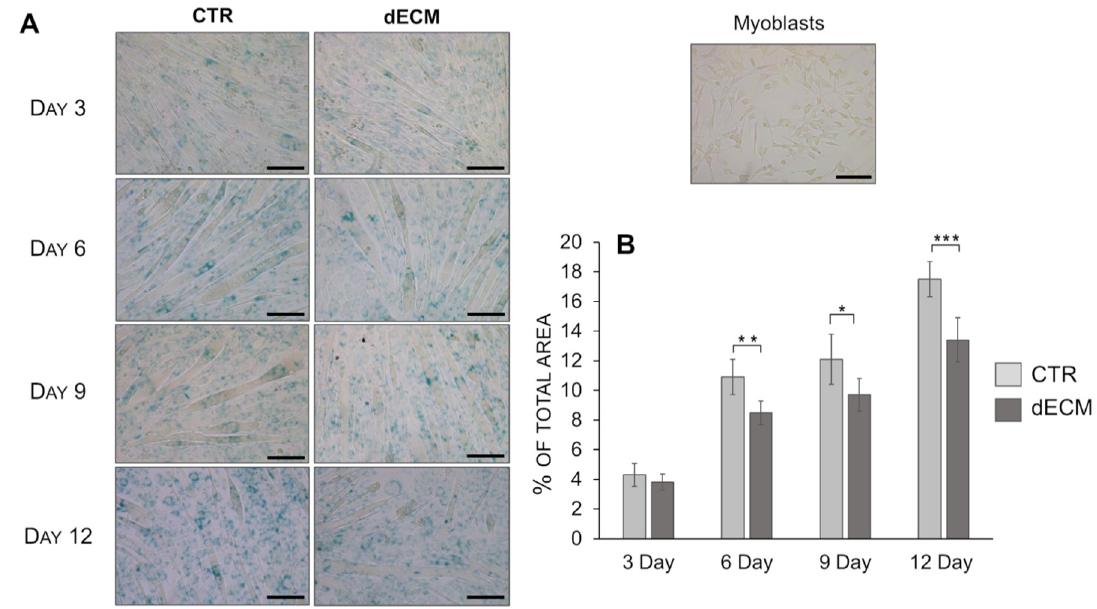
Figure 9. Representative images ( A ) of myotubes grown either on uncoated (CTR) or dECM pre-coated substrates up to 12 days and stained for the senescence-associated β -galacotosidase (SA- β Gal) marker. Quantification of SA- β Gal positive cells ( B ) expressed as percentage of total area ( n = 6). * p < 0.05, ** p < 0.01, *** p < 0.001. Scale bars: 100 µm.